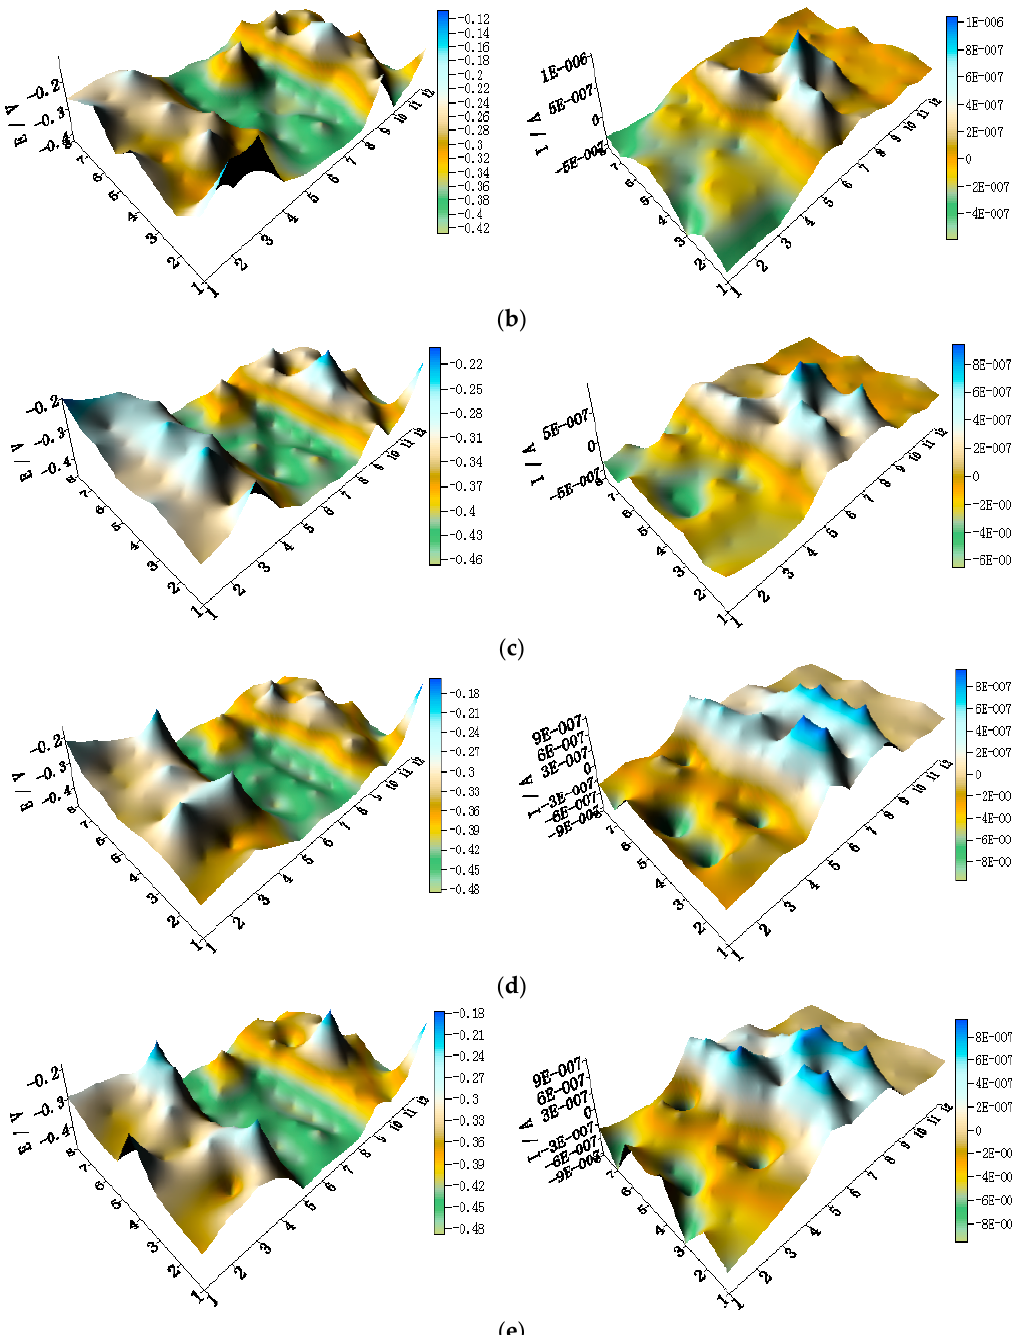
Figure 13. Spatial local potential (left, E vs. SCE/V) and current–density (right, I/A) distribution maps of WBE3 after being short-circuited for 12 h in artificial seawater at different temperatures: ( a ) 30 °C; ( b ) 40 °C; ( c ) 50 °C; ( d ) 60 °C; and ( e ) 70 °C.